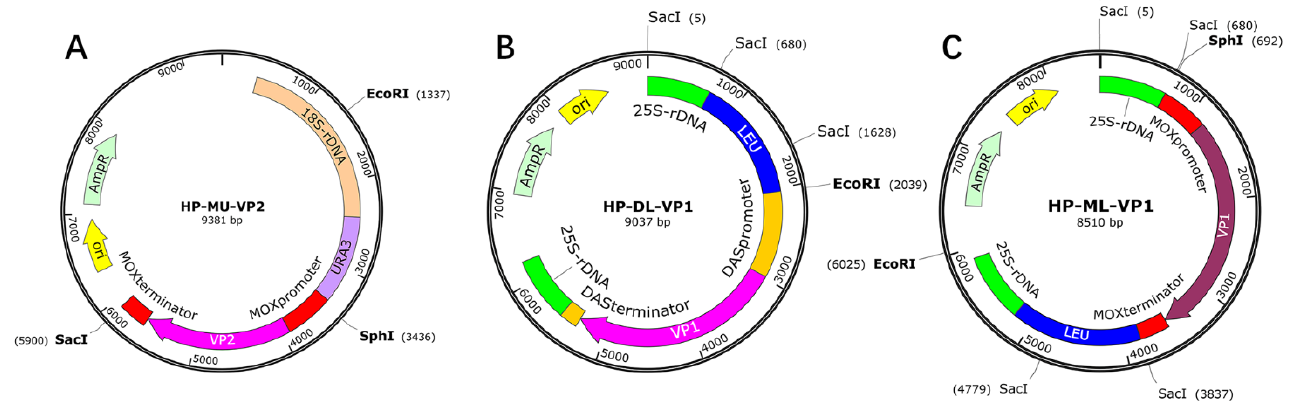
Figure 1. Schematic structures of the constructed VP2, VP1 and VP1h plasmids. ( A ): The constructed VP2 plasmid (HP ‐ MU). ( B ): The constructed VP1 plasmid (HP ‐ DL). ( C ): The constructed VP1h plasmid (HP ‐ ML).